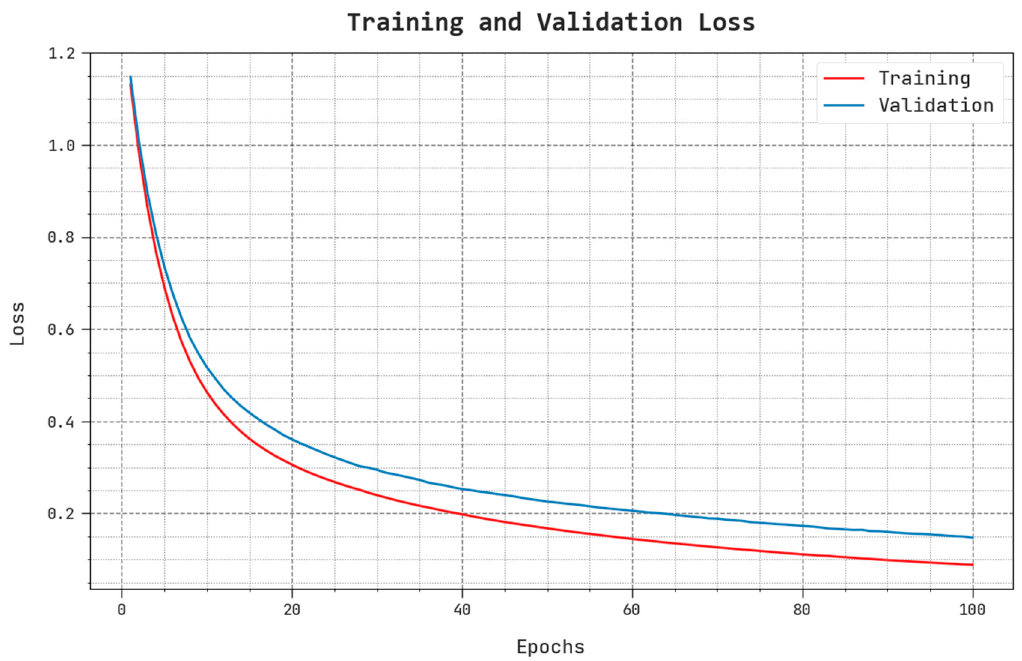
Figure 10. TLS and VLS outcomes of the BSBE-PPODLC approach.